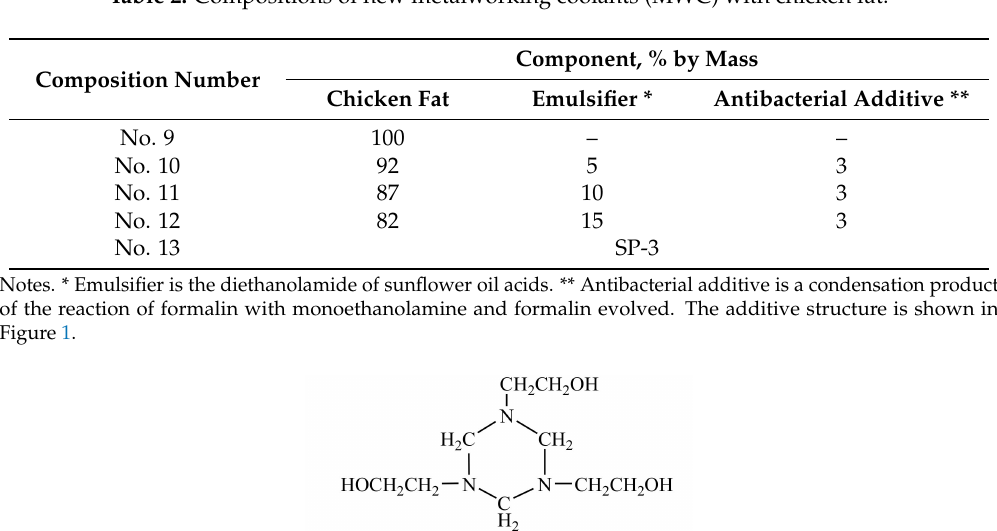
Table 2. Compositions of new metalworking coolants (MWC) with chicken fat.